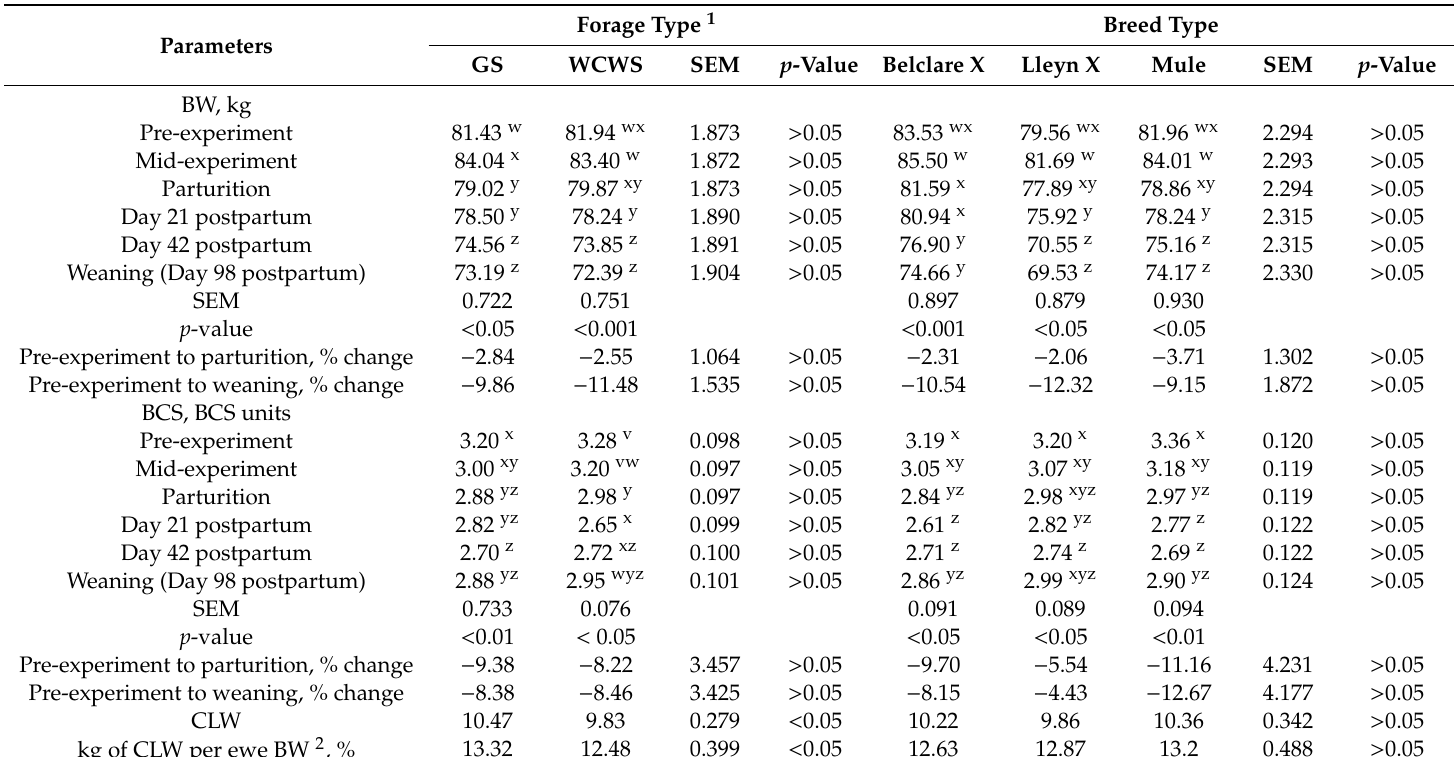
Table 4. The e ff ects of forage type and breed type on ewe body weight (BW) and body condition score (BCS) and combined litter weight (CLW; least square means ±